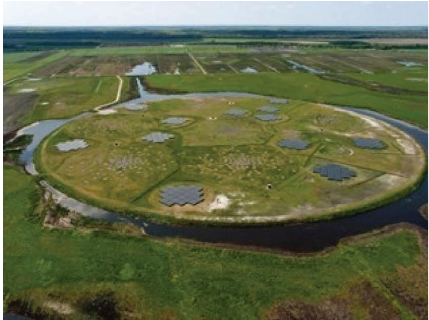
16: Low-frequency array (https://www.astron.nl/